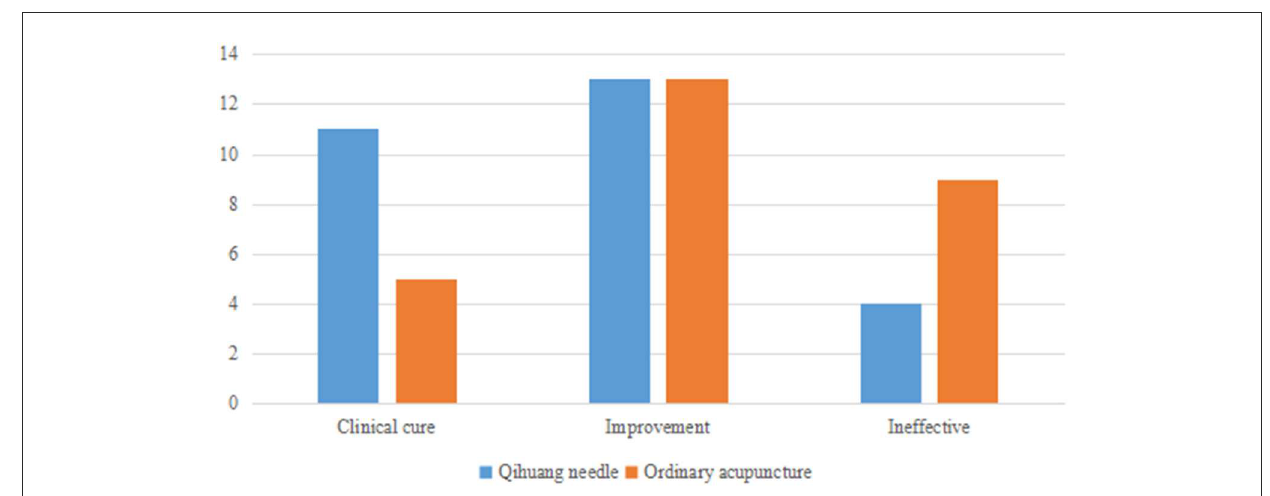
FIGURE3 A bar chart of statistics of clinical efficacy in two